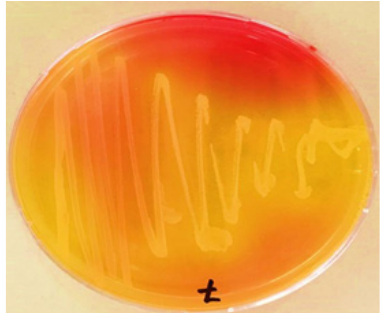
table 2. Number and percentage of bacteria isolated from UTI patients Bacterial